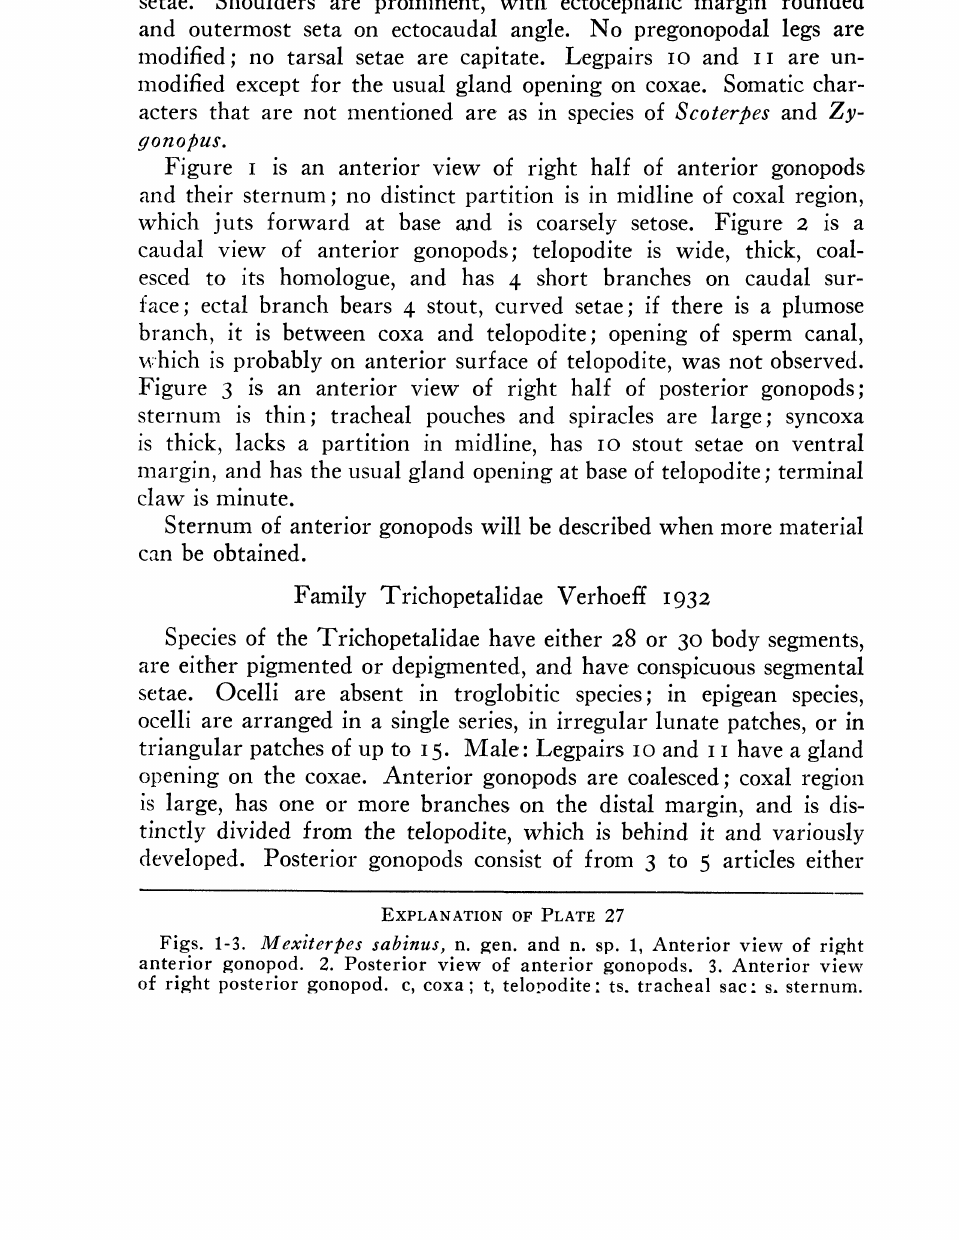
Figs. 1-3. Mexiteres sabinus, n. gen. and n. sp. 1, Anterior view of right anterior gonopod. 2. Posterior view of anterior gonopods. 3. Anterior vie of right posterior gonopod, c, coxa; t, telopodite: ts. tracheal sac: s.